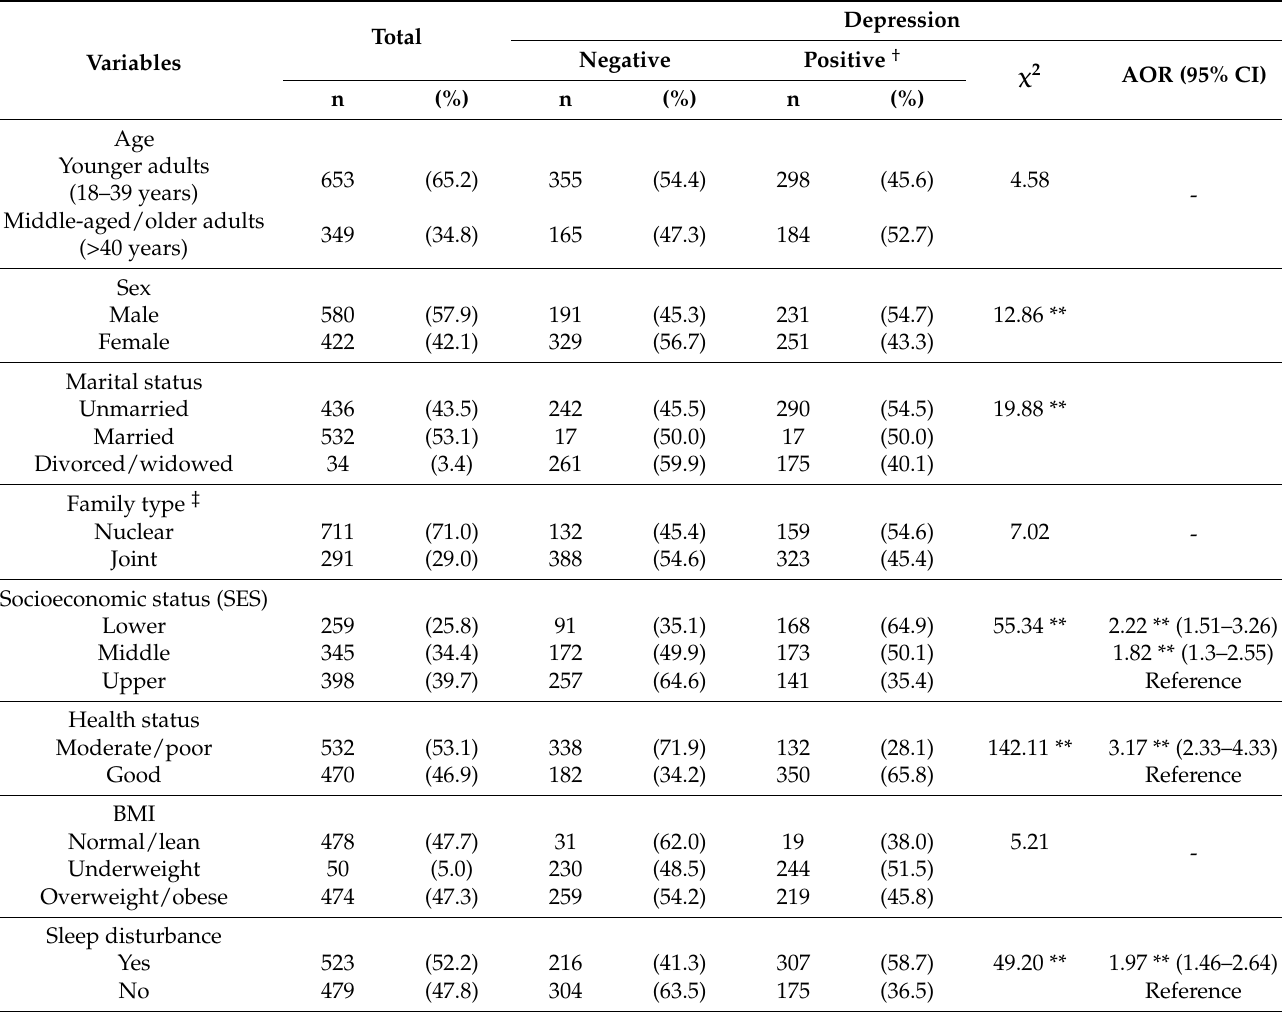
Table 1. Characteristics of people who were infected by severe acute respiratory syndrome coronavirus 2 (SARS-CoV-2) (experienced positive coronavirus disease (COVID-19) testing) and regression analysis predicting depression. Total Variables